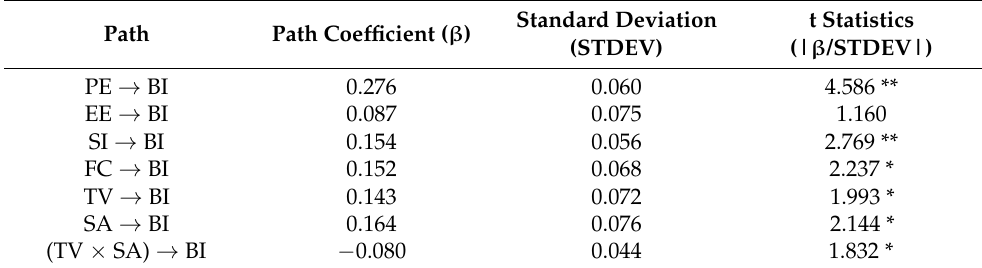
Table 8. Structural model assessment with inclusion of SA as the